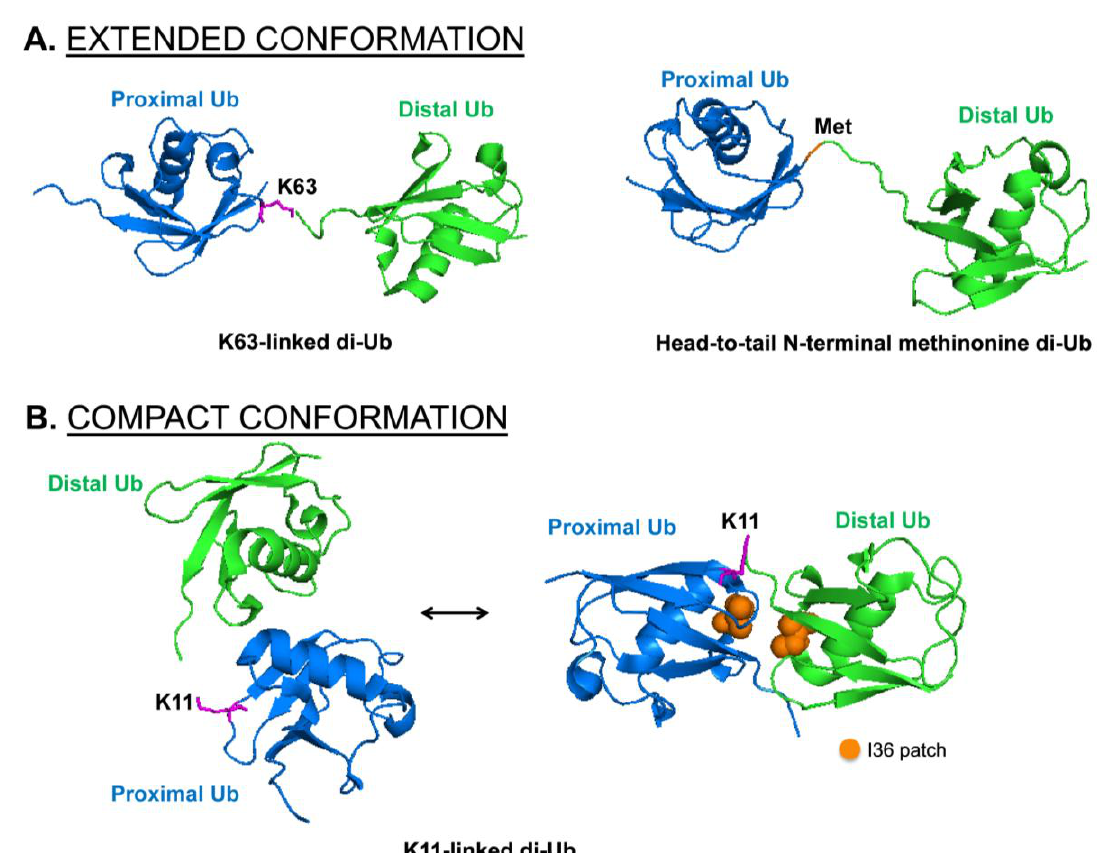
Figure 3. Different conformations of di-Ub